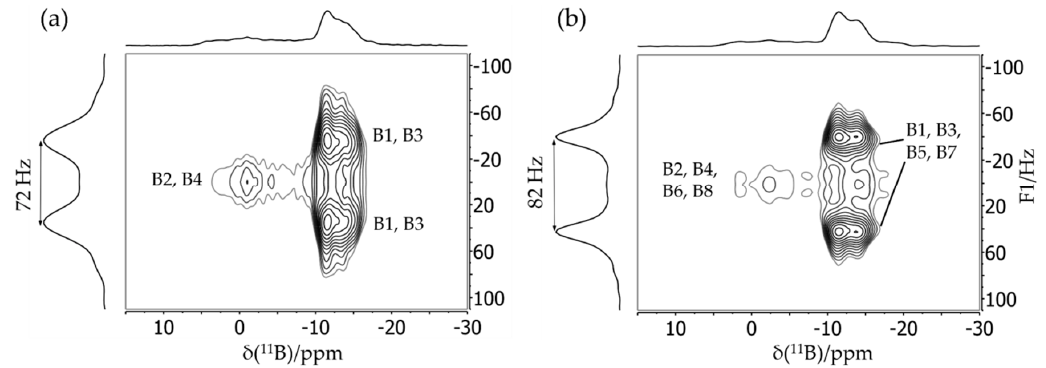
Figure 20. The 2D 11 B{ 31 P} J-resolved MAS NMR spectra of ( a ) 4 and ( b ) 5 . In ( b ), the additional sites B7 and B8 originate from an impurity.